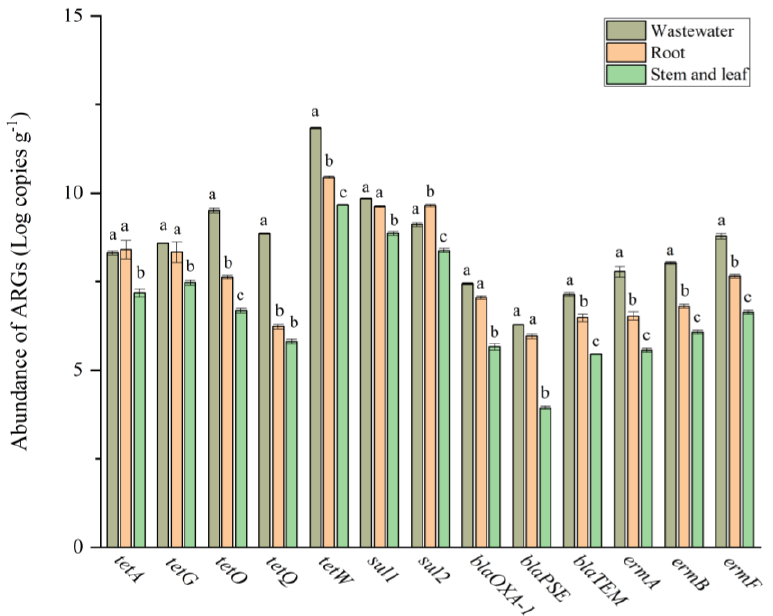
Figure 3. The abundance of antibiotic resistance genes (ARGs) in livestock wastewater and water dropwort. Different letters indicate significant differences between livestock wastewater, roots, and stems and leaves ( p < 0.05). and stems and leaves ( p < 0.05).